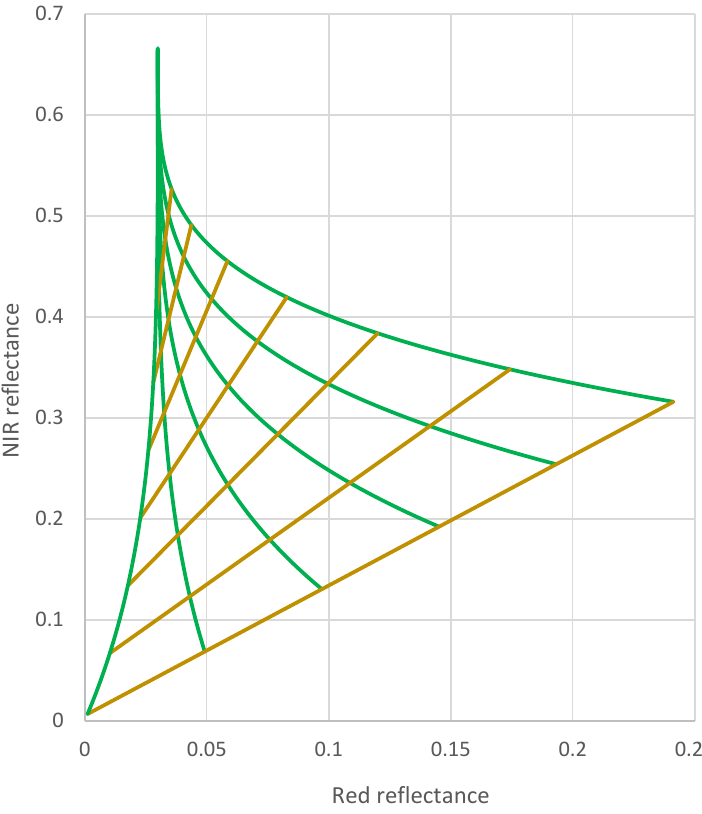
Figure 2. Feature space plot of modelled NIR vs. red bi-hemispherical reflectance for varying soil brightnesses and canopy LAIs. Lines of a varying LAI are shown in green and lines of a varying soil brightness are shown in brown.